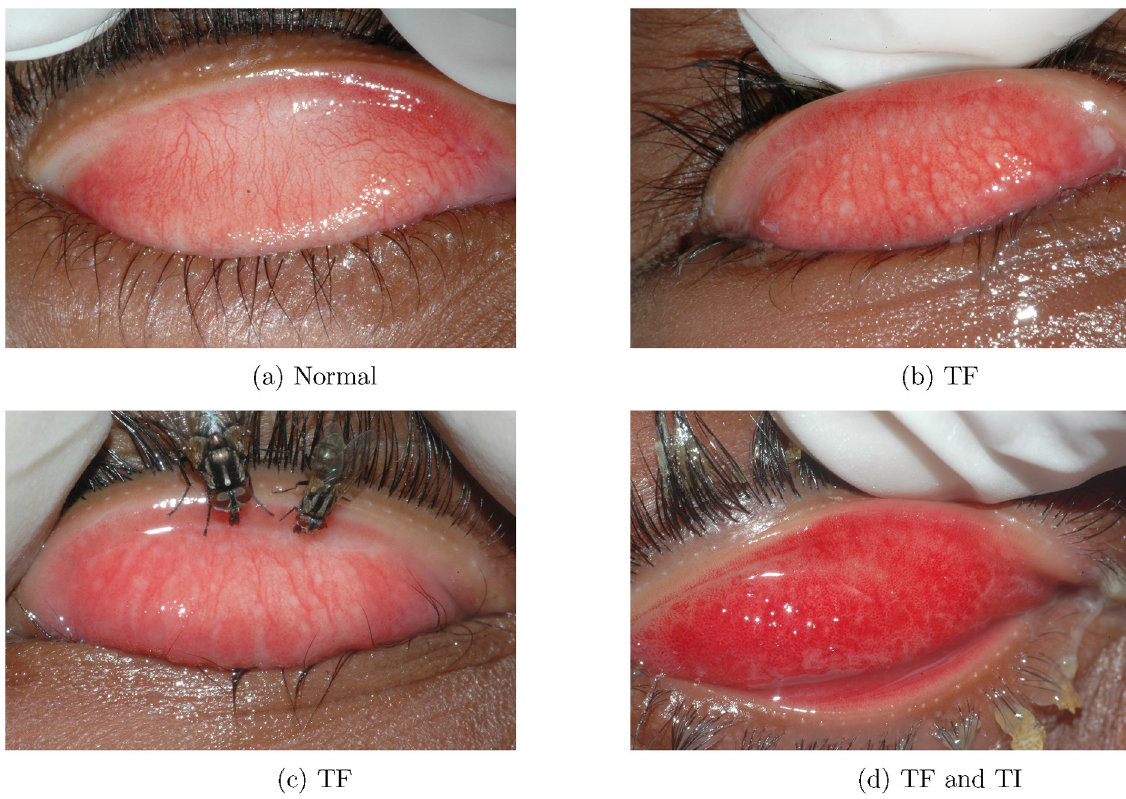
Fig 1. Trachoma classification of selected field collected images, according to the WHO simplified system. TF: trachomatous inflammation —follicular; TI: trachomatous inflammation—intense [16].